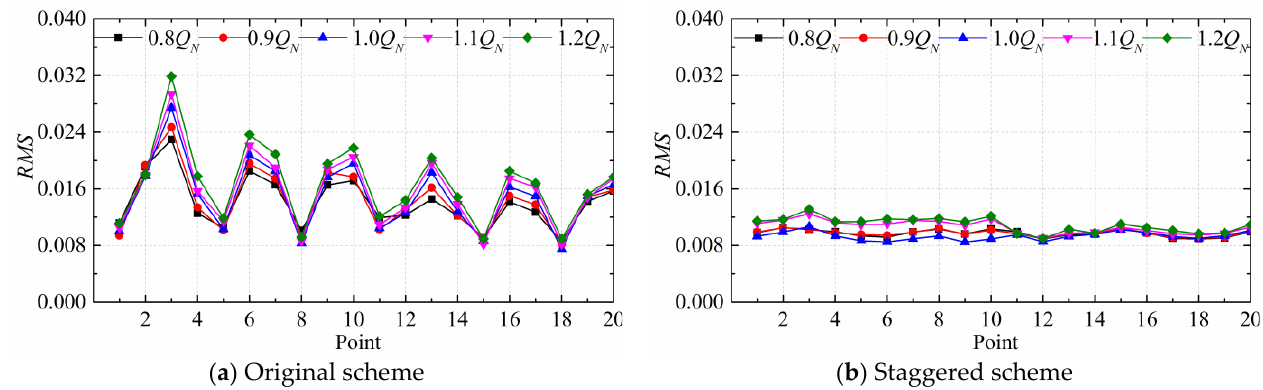
Figure 10. RMS of each measuring point in 0 – 4 f bpf frequency band.